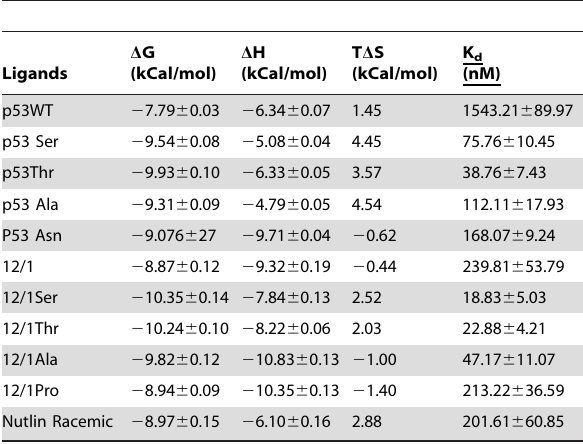
Table 1. Calculated K d s and thermodynamic parameters for the interactions between MDM2 and the derivative peptides.